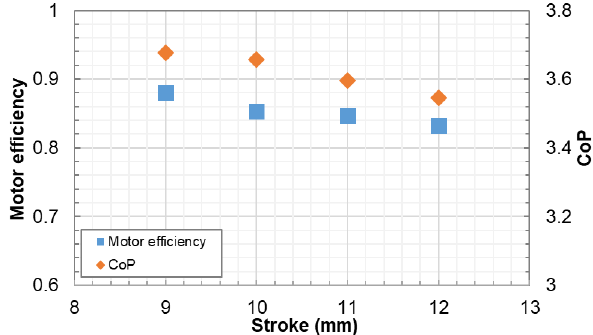
Figure 10. Motor e ffi ciency and CoP versus stroke with a fixed pressure ratio of 2.0 for the moving Figure 10. Motor efficiency and CoP versus stroke with a fixed pressure ratio of 2.0 for the moving magnet linear motor / magnet linear motor/compressor.